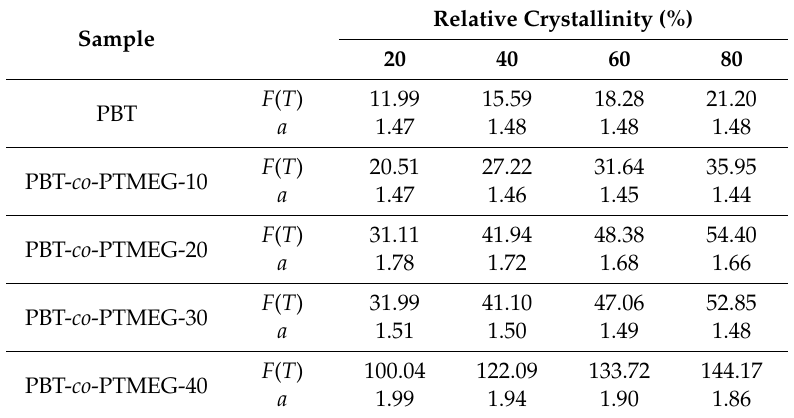
Table 4. Nonisothermal kinetic parameters for PBT and PBT- co -PTMEG copolymers obtained by Mo’s